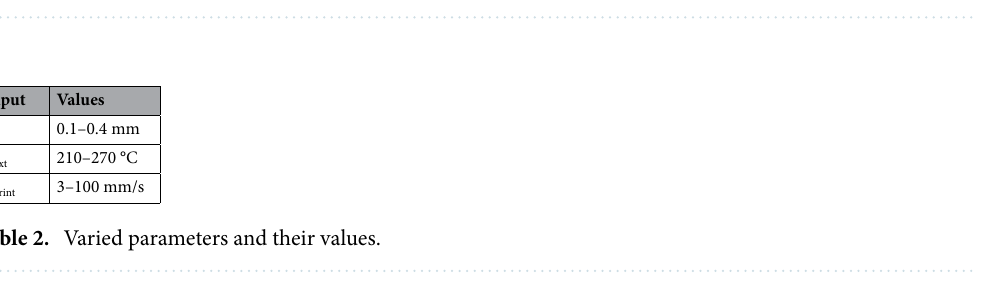
Table 1. Summary of model inputs and printing conditions.